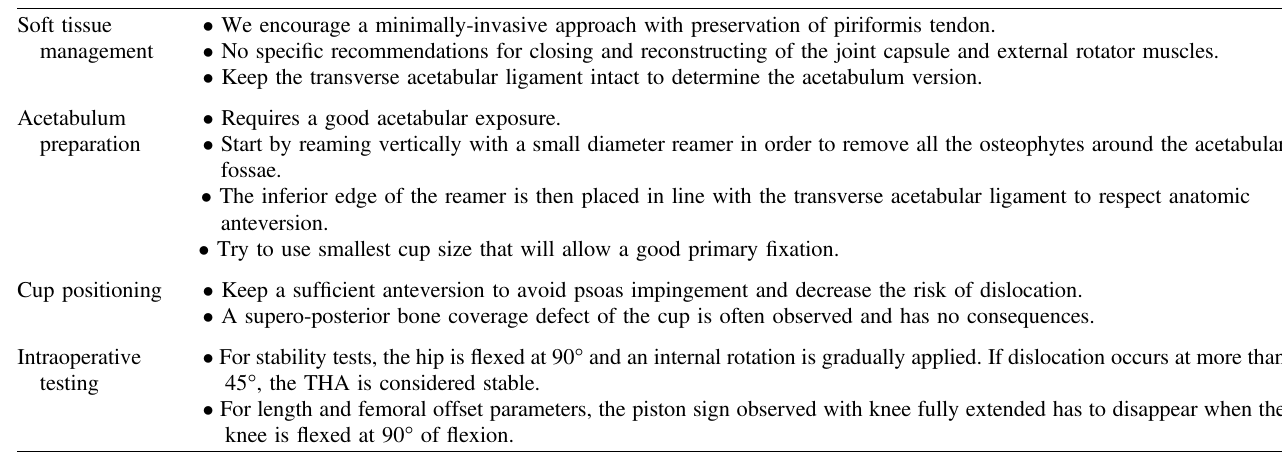
Table 3. Tips and tricks for posterior